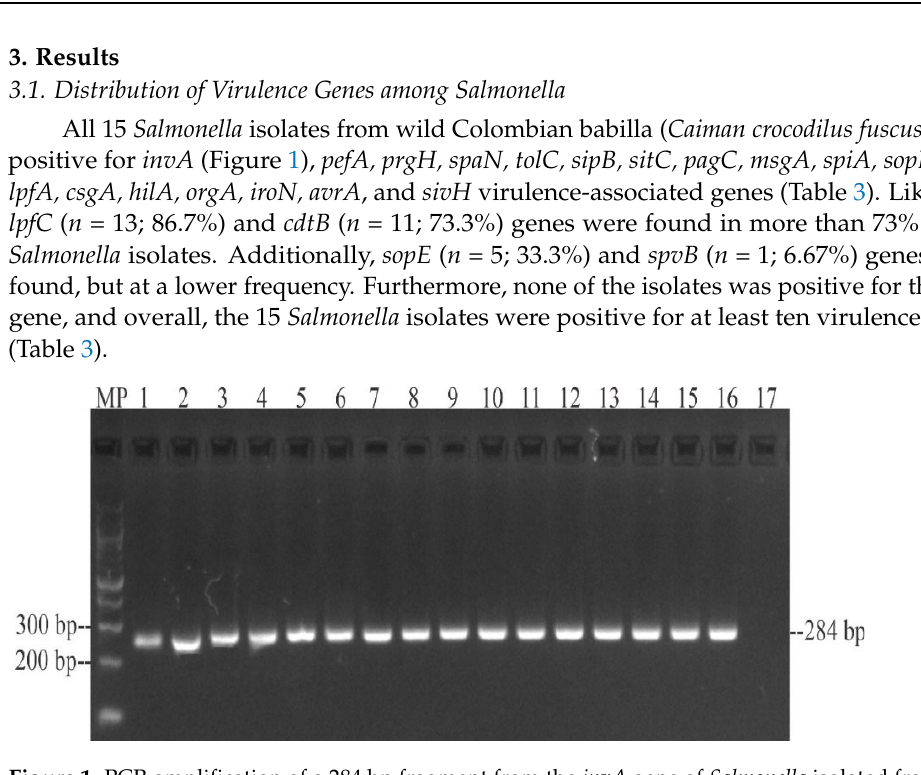
Figure 1. PCR amplification of a 284 bp fragment from the invA gene of Salmonella isolated from